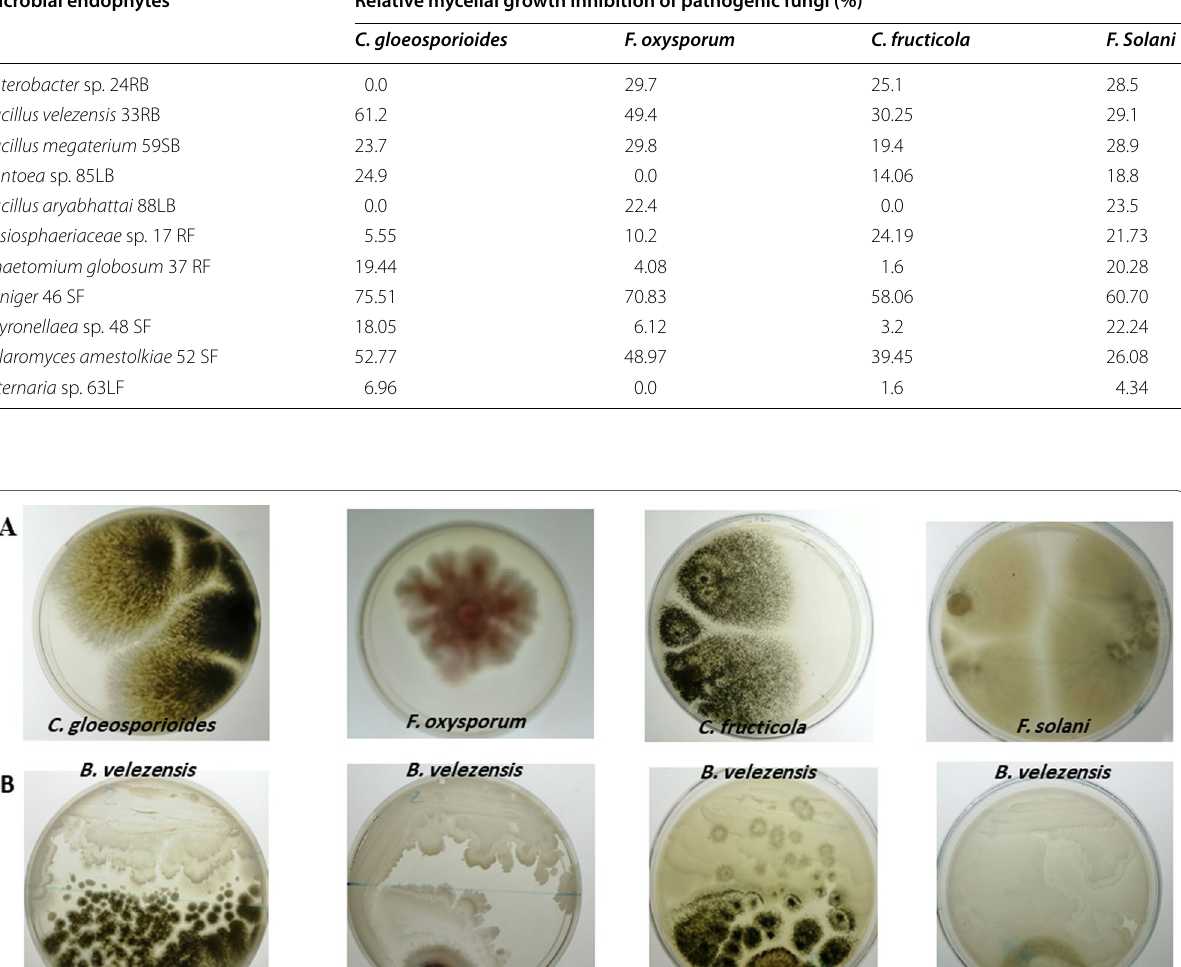
Table 1 Effect of endophytic microbes on growth inhibition of plant pathogenic fungi Microbial endophytes